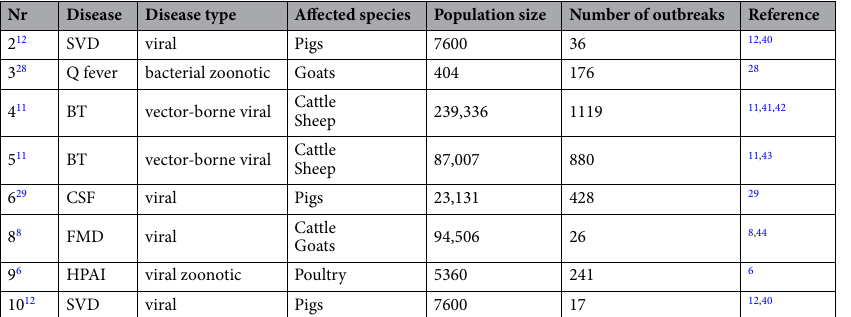
Nr Disease Disease